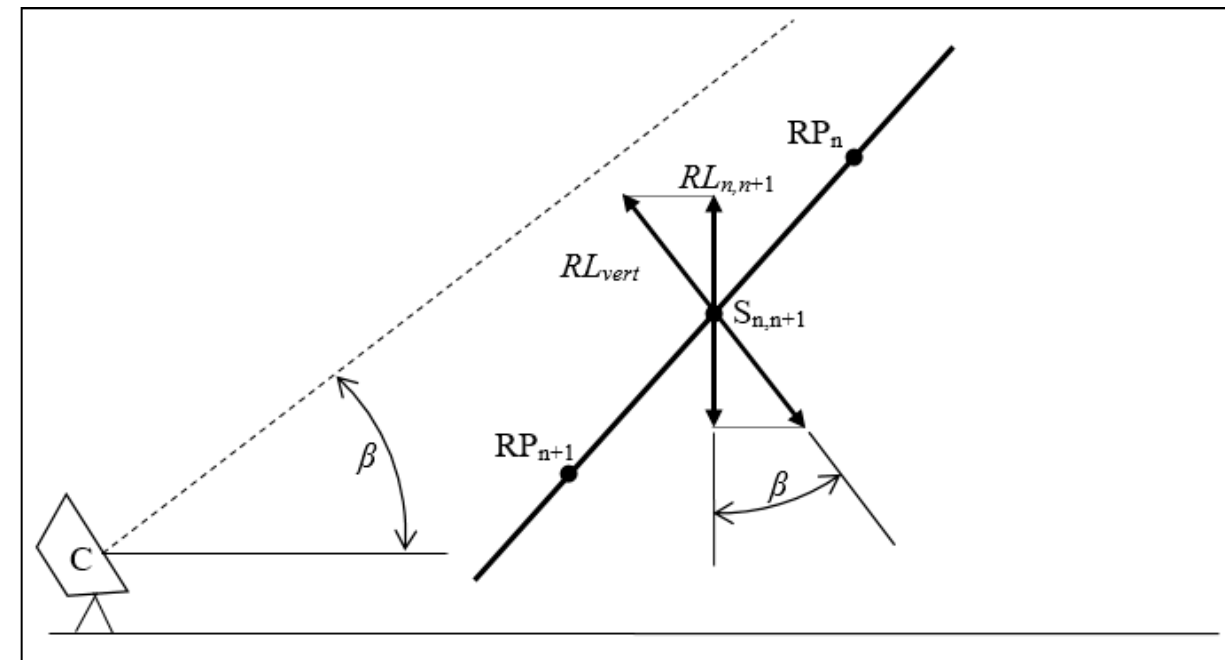
Appl. Sci. 2021 , 11 , x FOR PEER REVIEW Figure 11. Correction of the reference length for a rotation in the vertical axis (source: The authors of this article).